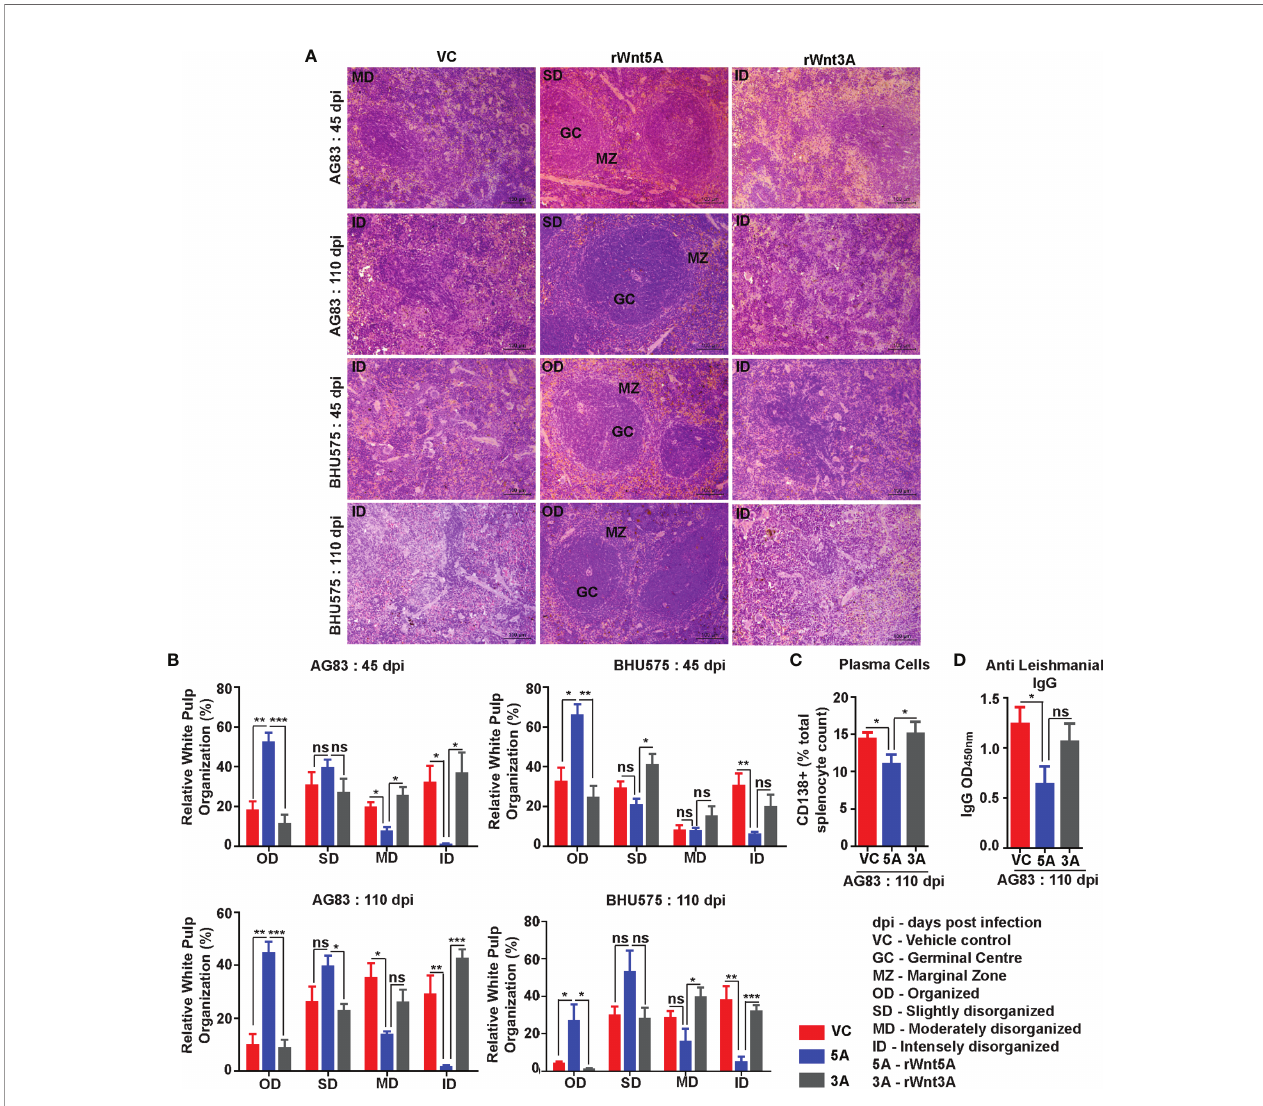
FIGURE 5 | Treatment of mice with rWnt5A inhibits L. donovani infection induced disorganization of splenic white pulp. (A) Representative micrographs of Hematoxylin & Eosin stained sections of spleen (under 20X objective) depicting signi fi cantly less disorganization in splenic white pulp subject to rWnt5A, but not rWnt3A or VC treatment, prior to AG83 or BHU575 infection. (B) Graphical representation of extent of preservation of splenic white pulp organization by rWnt5A treatment before infection as compared to rWnt3A or vehicle control. (C, D) Graphical representation of lower percentage of CD138 + plasma cells (C) and lower level of anti-leishmanial IgG (D) in rWnt5A pretreated infected mice as compared to those pretreated with rWnt3A or VC. Data are presented as mean ± SEM. Statistical analysis was performed with the unpaired t-test. Signi fi cance was annotated as follows: * p ≤ 0.05, ** p ≤ 0.005, *** p ≤ 0.0005. ns, not signi fi cant, n=4 to n=6 (per